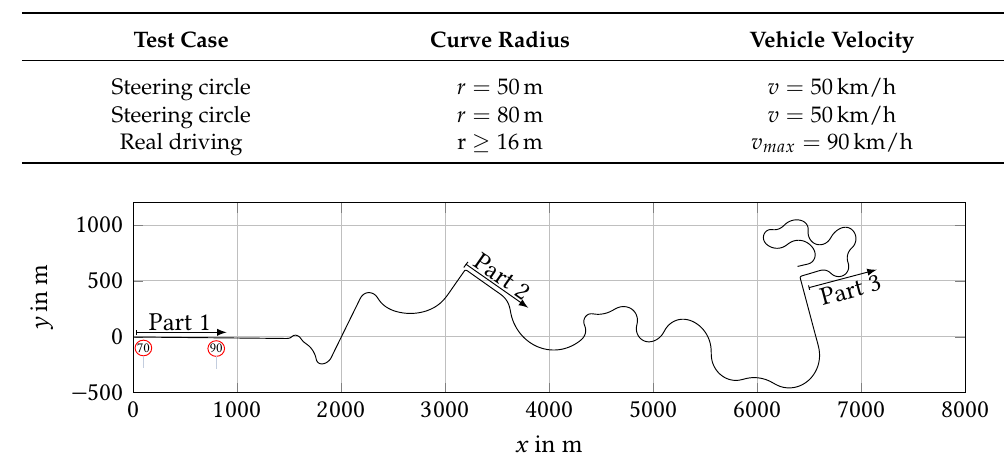
Table 5. Performed cornering cases.